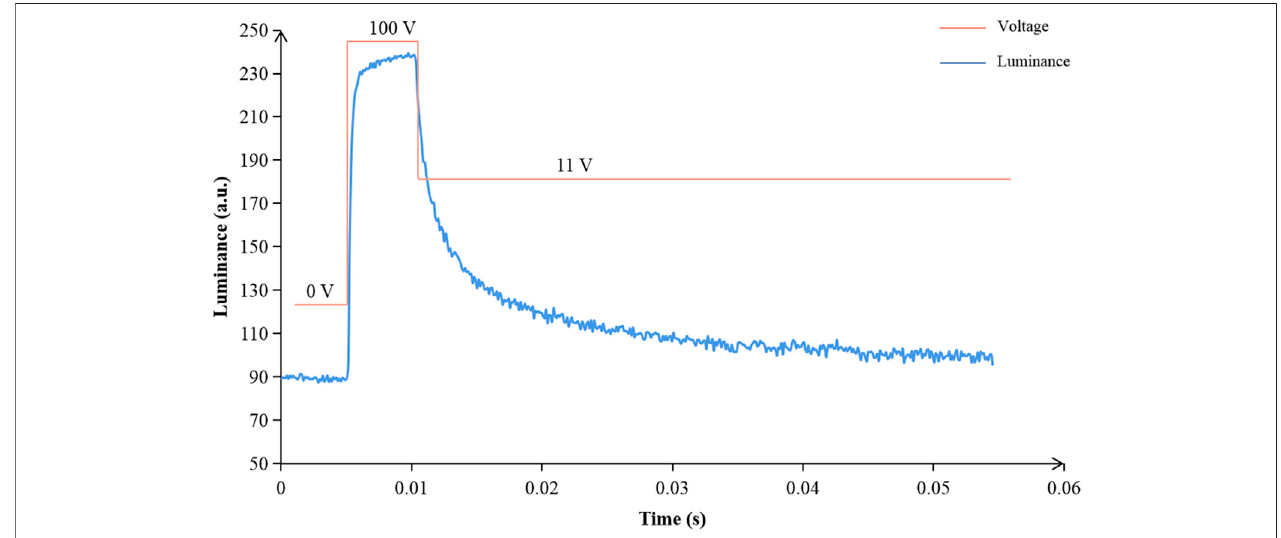
FIGURE 13 | Diagram of an overvoltage driving waveform and the response curve of EWDs with a 100 V overvoltage. The proposed driving waveform contained two stages. The fi rst stage was an overvoltage for accelerating the oil fi lm motion. The second stage was used to maintain the pixel opening state by a normal driving voltage.